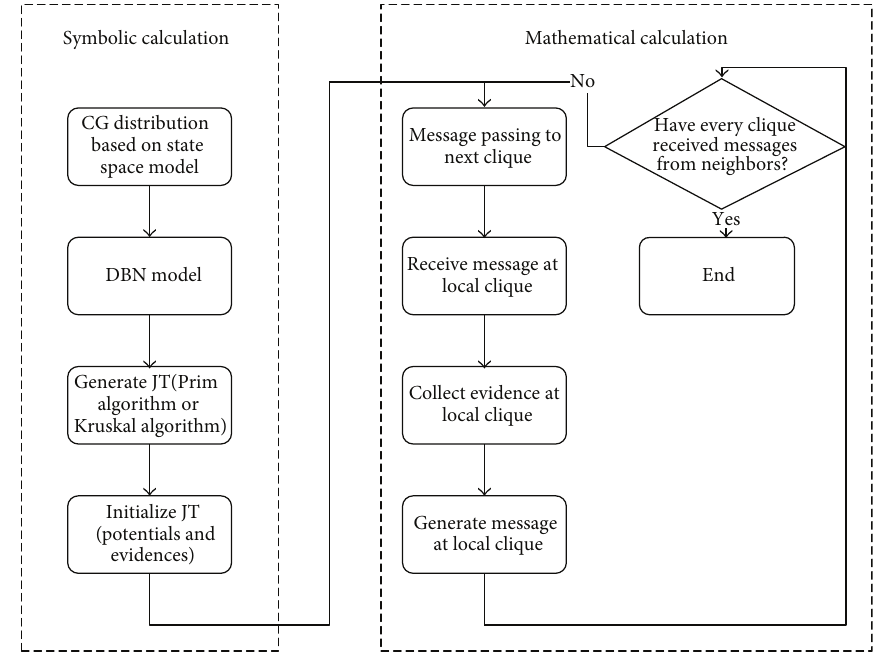
Figure 2: Flowchart of